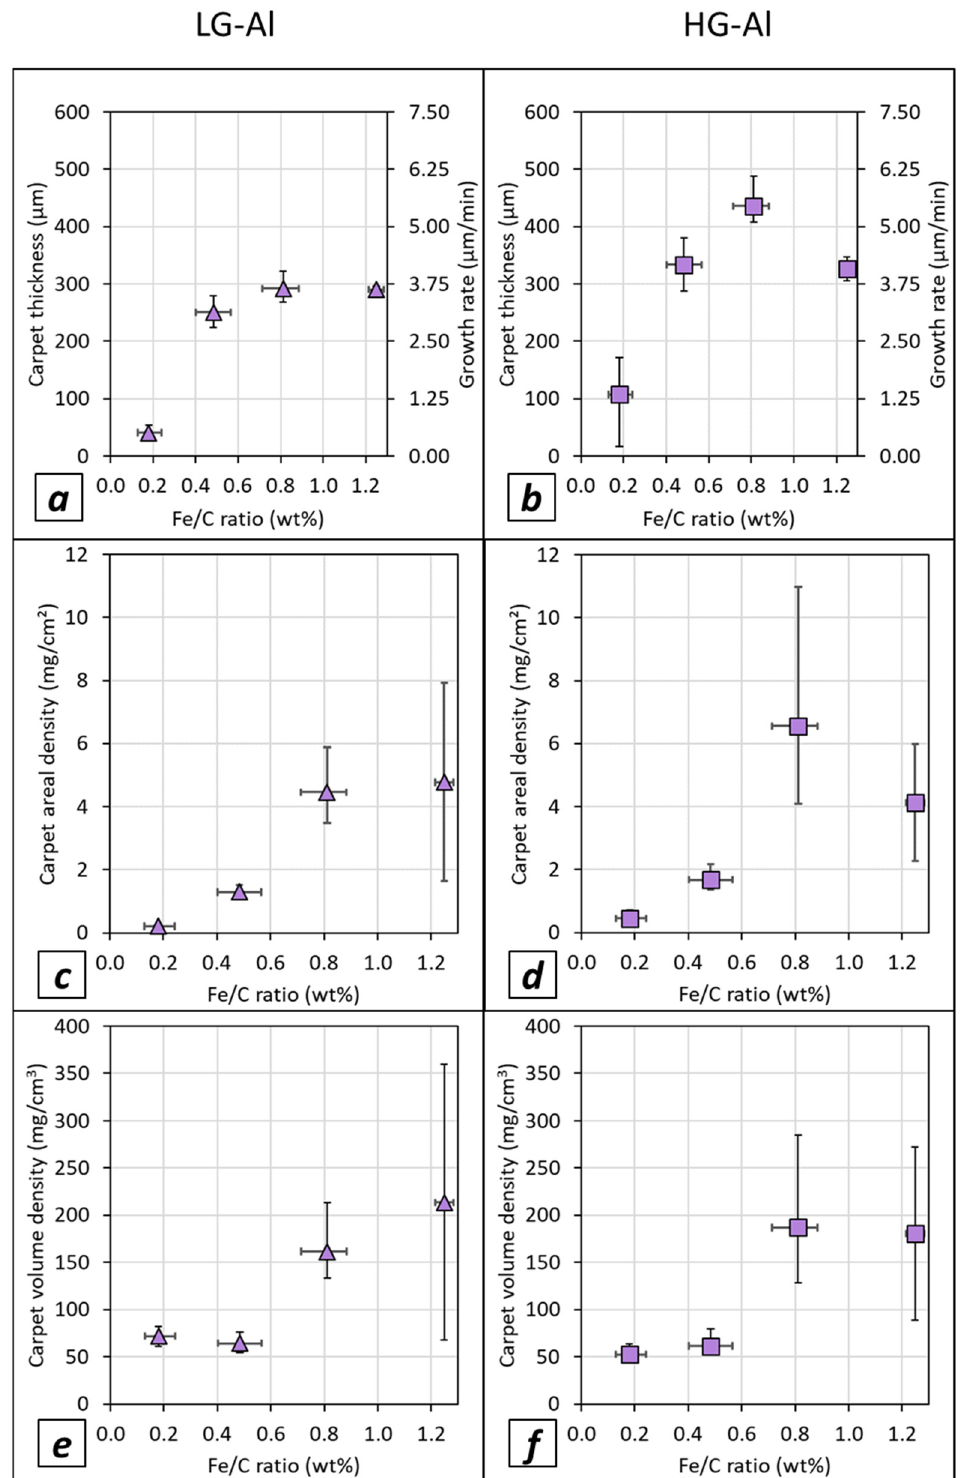
Figure 9. Carpet thickness, areal density and volume density versus Fe/C ratio for synthesis per- formed with 1.5 vol% of acetylene during 80 min: ( a – c ) on LG-Al substrate; ( d – f ) on HG-Al substrate. The variation range on the horizontal axis corresponds to the minimum and maximum values in- vestigated around the mean value, and the variation range on the vertical axis corresponds to the minimum and maximum of the mean values